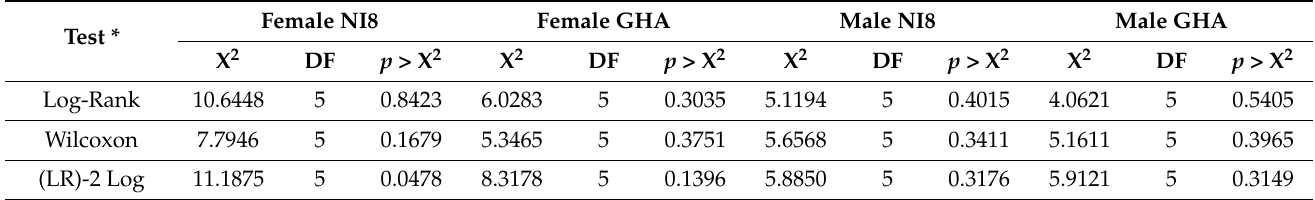
Table 2. Test of Equality over Strata LIFETEST for Nezara viridula female and male treated with 2 dif- ferent strains of Beauveria bassiana , native NI8 and commercial GHA, scored at 20 days after exposure.